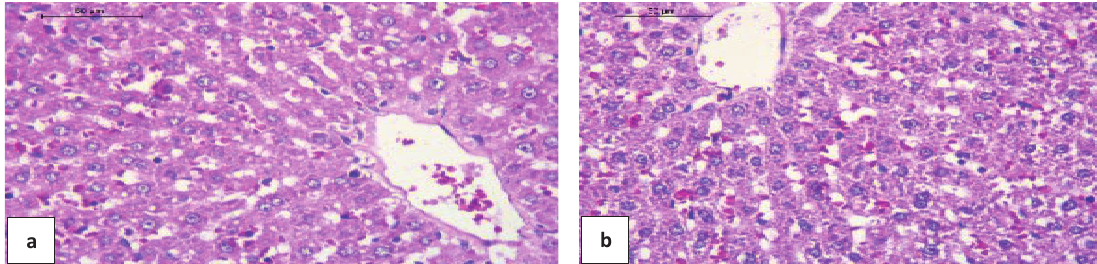
Figure 2. Histopathology of Liver Wistar rat 400x by Hematoksilin Eosin (HE). Comparison between histopathological features in control group (a) and second treatment group (b). Seem histopathological features in second treatment group has similar features compared to control group.